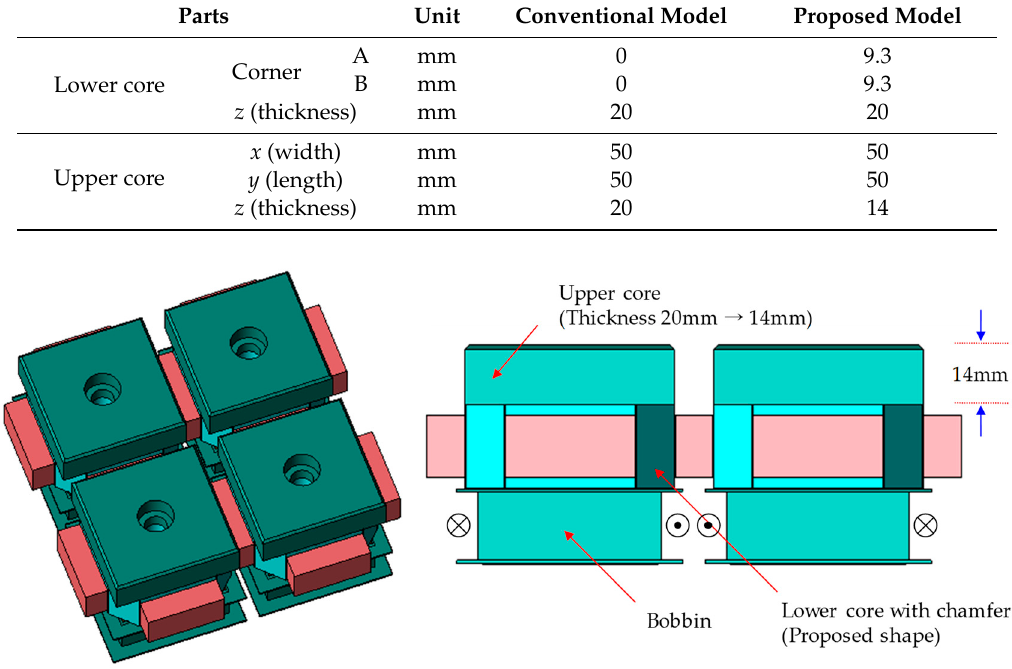
Figure 18. Model of the proposed H-EMM combining all shape modifications.